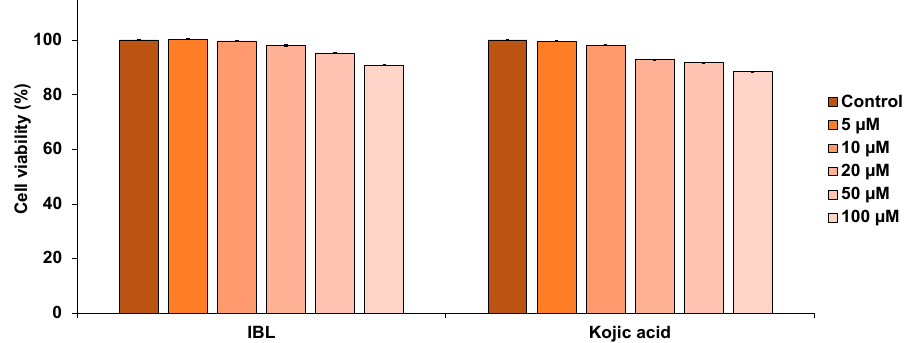
Figure 2. Effect of IBL on cell viability in B16F10 cells. After incubation of B16F10 melanoma cells with various concentrations of IBL (5–100 µM) in a 96-well plate for 24 h, cell viability was determined through the MTS assay. Values are represented as means ± SEM ( n = 3).